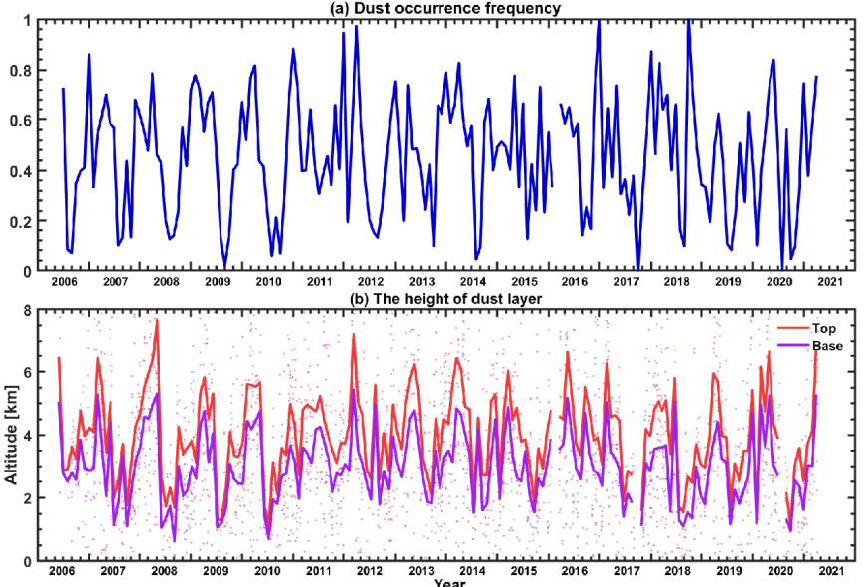
Figure 3. Monthly-averaged dust occurrence frequency ( a ), and the averaging top and base heights of the dust layers ( b ) over the Jianghan Plain from June 2006 to March 2021 obtained from nighttime CALIOP level-2 Vertical Feature Mask data. The solid lines in ( b ) denote the monthly averaged altitudes; each point in ( b ) denotes the height for each dust layer. No valid data are available